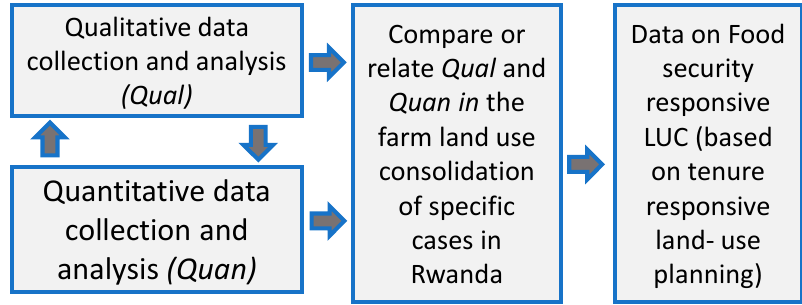
Figure 3. Convergent parallel mixed methods research design.